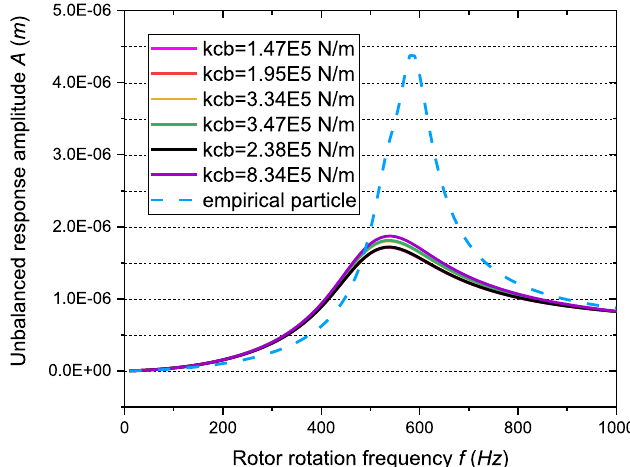
Fig. 10. Verify the effect of the stiffness coef fi cient of the gas bearing with ori fi ce for d s = 0.12mm on the synchronous responses of the